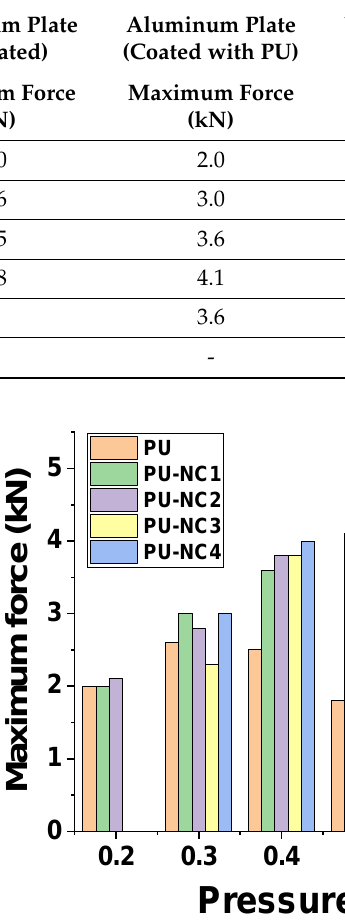
Figure 10. Maximum force values obtained during the impact tests with Hopkinson bar.